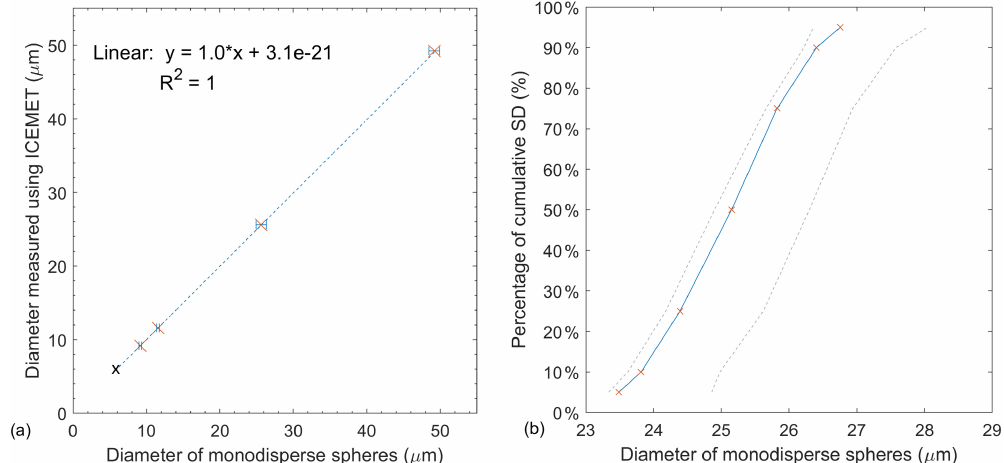
Figure 3. (a) The results of calibration measurements for ICEMET with a 95% confidence level given by the manufacturer after the size correction was applied as well as a 1 : 1 line (dashed). The 5µm particles were not certified and therefore the uncertainty value was not defined (black cross). (b) The measured cumulative size distribution using the ICEMET sensor using 25.6µm monodisperse microspheres. The uncertainty limits specified by the manufacturer are marked as dashed lines.